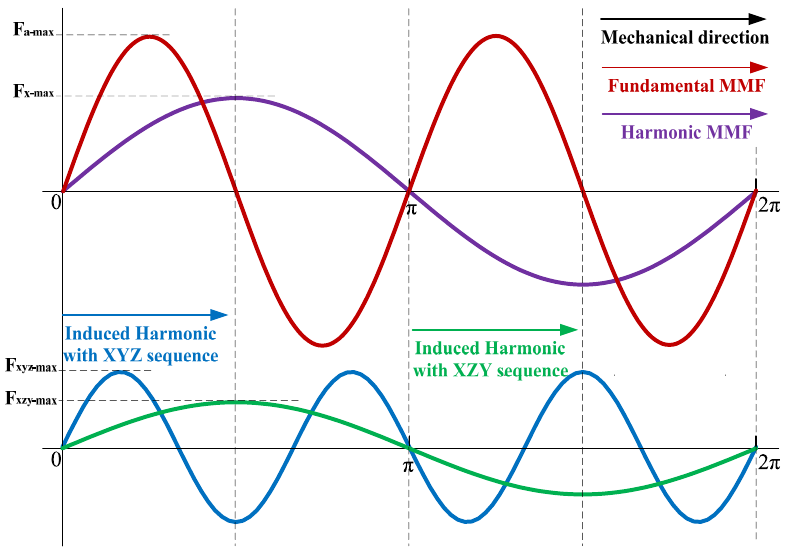
Figure 4. Illustration of the fundamental MMF, harmonic MMF, and the induced harmonics in the